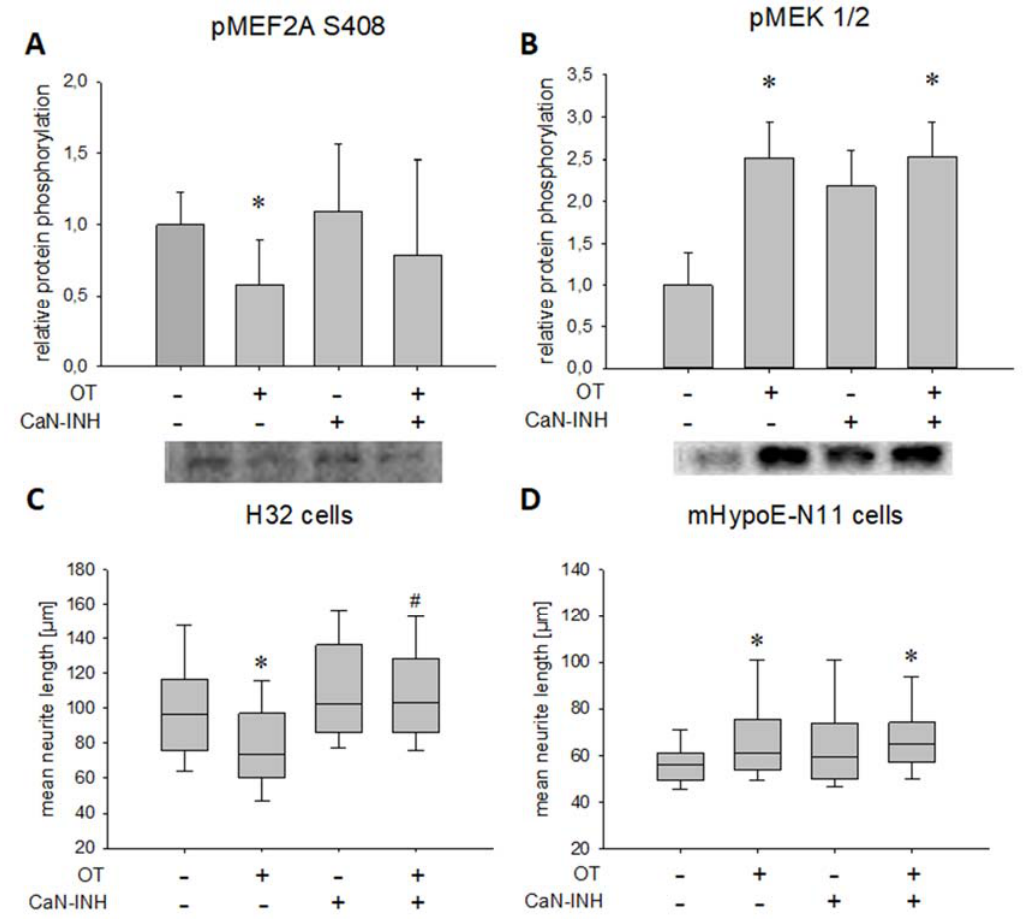
Figure 3. E ff ect of OT stimulation and calcineurin inhibition on phosphorylation of S408 of MEF2A and MEK1 / 2 as well as on the median neurite length in H32 cells. ( A ) Relative MEF2A S408 phosphorylation analyzed by Western blotting in whole cell lysate after treatment with VEH and OT, in the presence or absence of a CaN inhibitor (CaN-INH), with representative blot below. Overnight incubation of H32 wild-type cells with 100 nM OT led to a significant dephosphorylation of MEF2A at S408 compared to VEH treated cells (one-way ANOVA, p = 0.056; independent t-test VEH vs. OT, p = 0.006). This e ff ect is dependent on CaN activity, as it is reversed to basal by a CaN-INH. The inhibitor without OT had no e ff ect on MEF2A phosphorylation. n = 6 per treatment. ( B ) Relative phosphorylation of MEK1 / 2 analyzed by Western blotting in whole cell lysate after treatment with VEH and OT, in the presence or absence of a CaN inhibitor, with representative blot picture below. Treatment of the cells with 100 nM OT overnight led to a significant phosphorylation of MEK1 / 2 compared to VEH. Statistical analysis using one-way ANOVA revealed no significant e ff ect of the inhibitor treated cells, but a significant phosphorylation of MEK1 / 2 when cells were treated with OT and the CaN-INH. n = 6 per treatment; * p < 0.05 vs. VEH. ( C ) In H32 cells, 100 nM of OT led to a significant retraction compared to VEH, while inhibition of CaN resulted in elongation of neurites overnight compared to VEH and OT. Combining the OT treatment with a CaN-INH increased the neurite length significantly. n = 100 per treatment; * p < 0.001 vs. VEH-treated cells; # p < 0.001 vs. OT-treated cells. ( D ) Incubation of mHypoE-N11 cells with 100 nM OT overnight led to an increased neurite length. Inhibition of CaN had no e ff ect on the neuronal morphology, in line with the absent MEF2A expression in this cell line. n = 50 per treatment; * p < 0.05 vs. VEH-treated